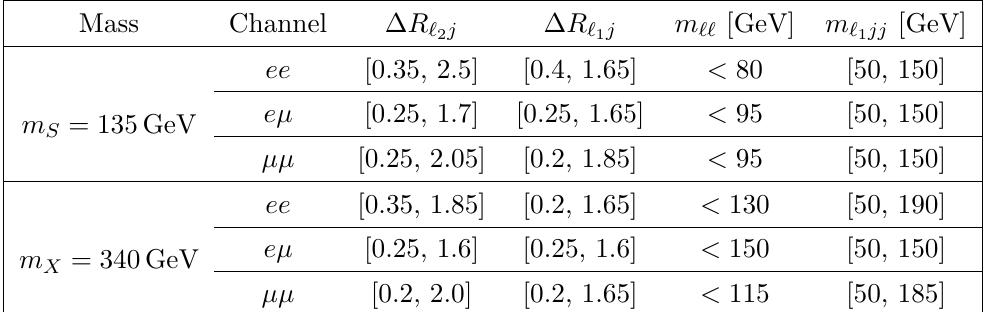
Table 6 . Optimised selection criteria used in the two lepton channel in the X ! SS search. The selection criteria in the (cid:12)rst row are used for m S = 135 GeV and m X = 280, 300, and 320 GeV. The selection criteria in the second row are used for m X = 340 GeV and m S = 135, 145, 155, and 165 GeV.